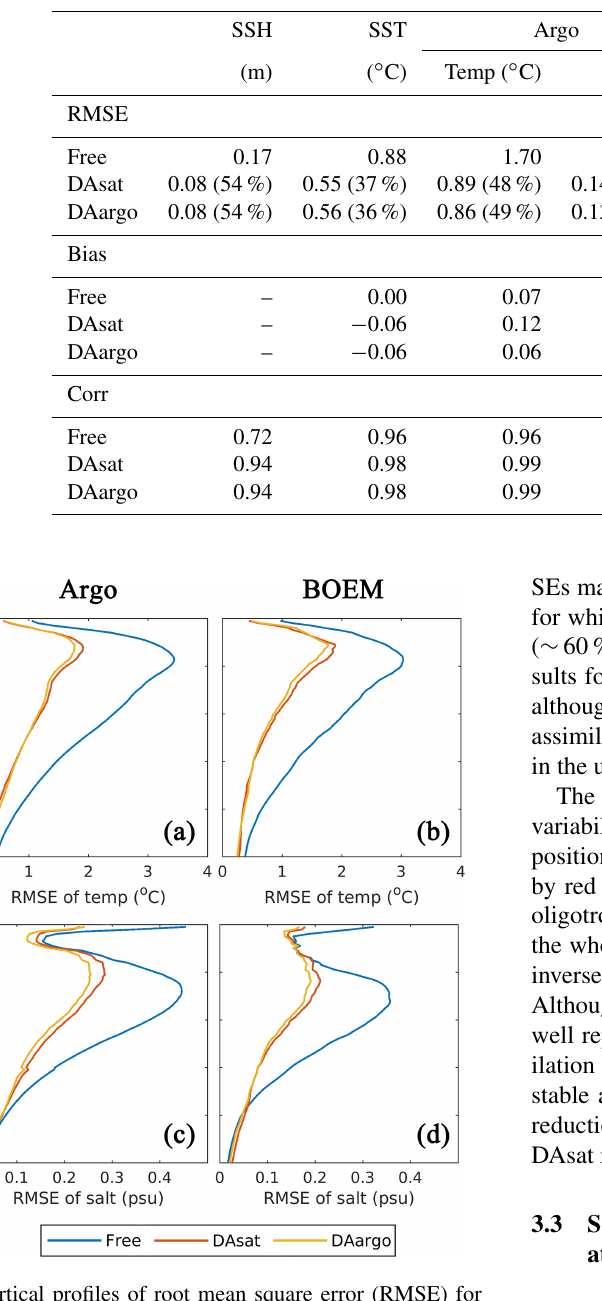
Table 1. The root mean square error (RMSE), bias, and correlation coefficient (Corr) for SSH and SST, as well as vertical profiles of temperature and salinity from Argo and BOEM floats. Percentages in the parentheses represent the relative reductions in RMSE values. Since the spatial and temporal average of mismatch between the modeled and observed SSH is removed, the bias of SSH is not shown here.